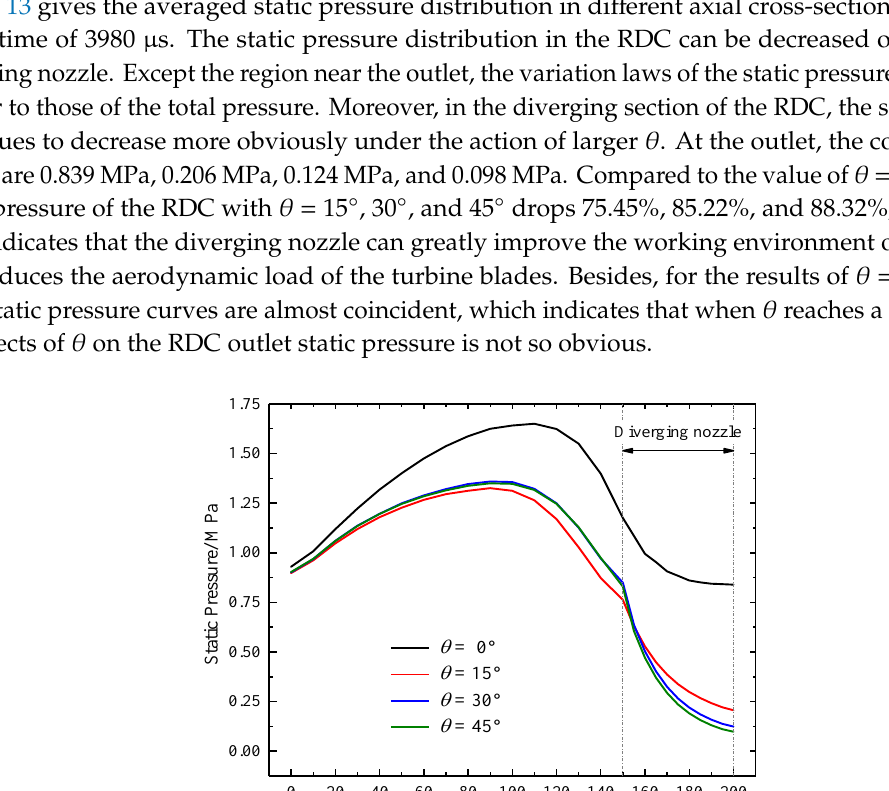
Figure 12. The averaged total pressure in different axial cross-sections of the RDC at t = 3980 μs.